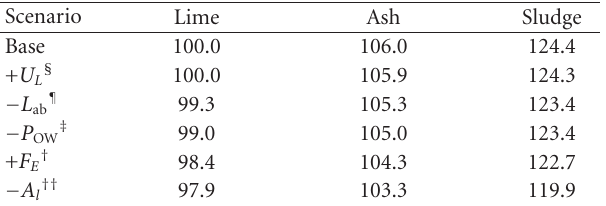
Table 7: Sensitivity of emergy requirements to alternative manage- ment (base data